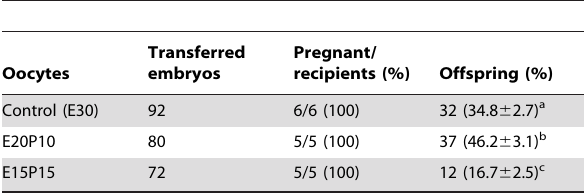
Table 2. In vivo development of mouse oocytes vitrified with